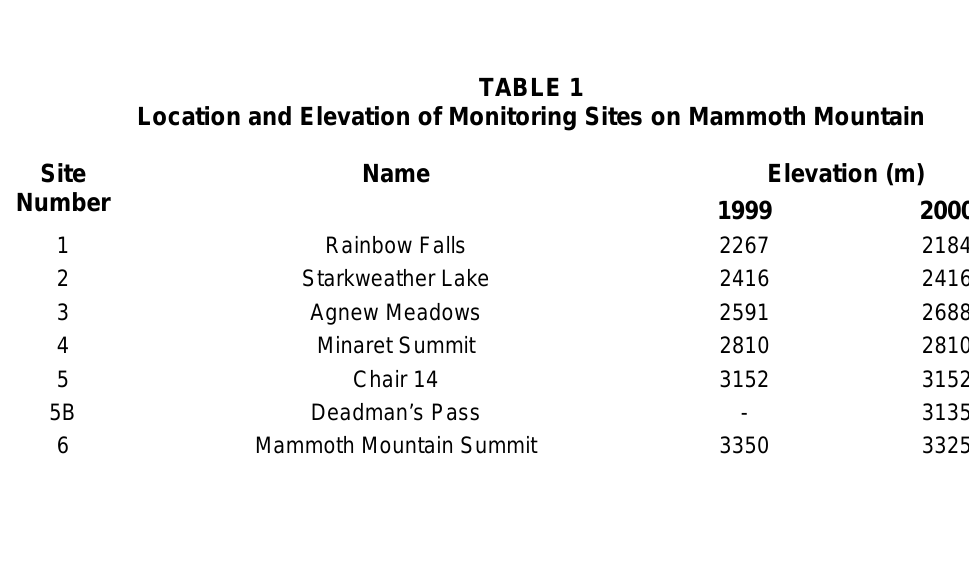
FIGURE 1 . Location of Mammoth Mountain in Sierra Nevada, California.